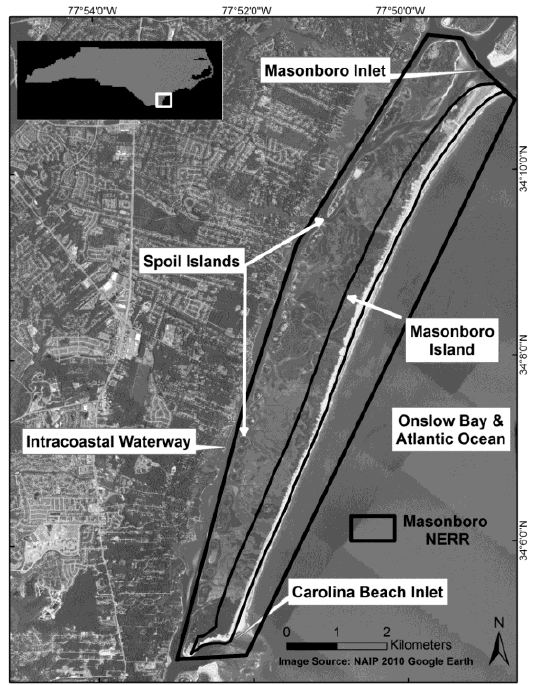
Figure 1. Masonboro Island National Estuarine Research Reserve is an undeveloped and protected area off the coast of Wilmington, North Carolina,